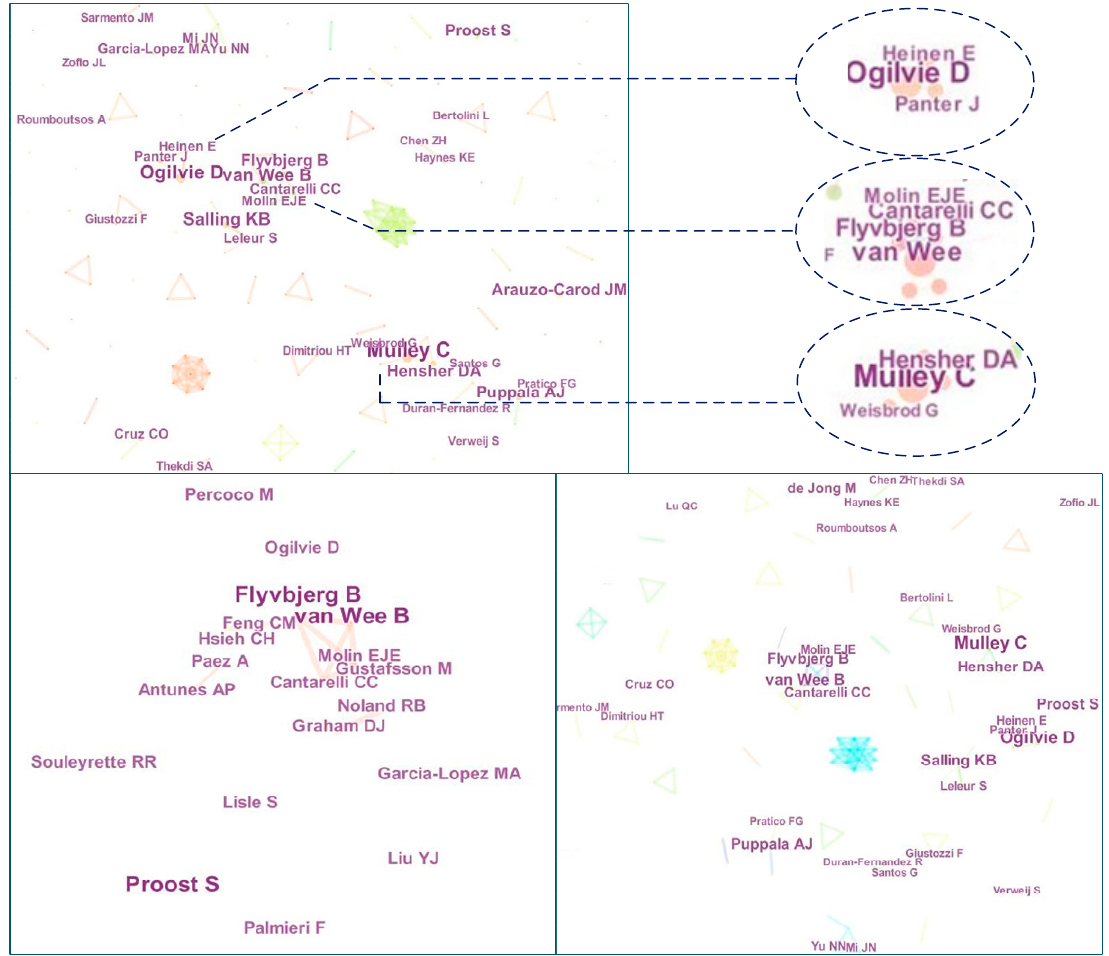
Figure 4. Comparison of author collaboration networks.